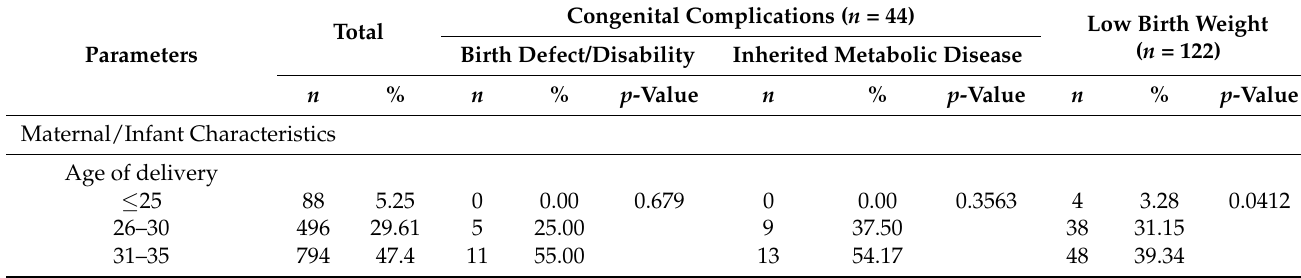
Table 1. General Characteristics of study participants and health-related/nutritional behaviors during